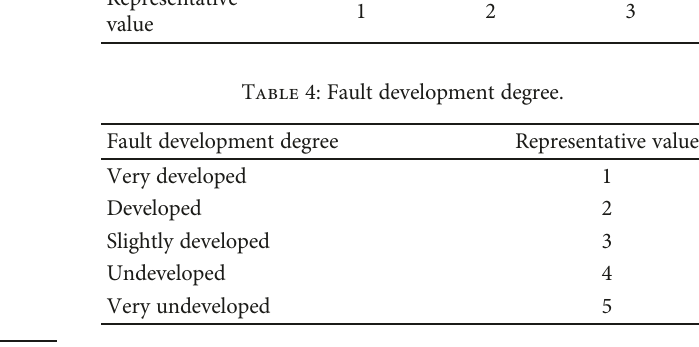
Table 5: Fault activity.